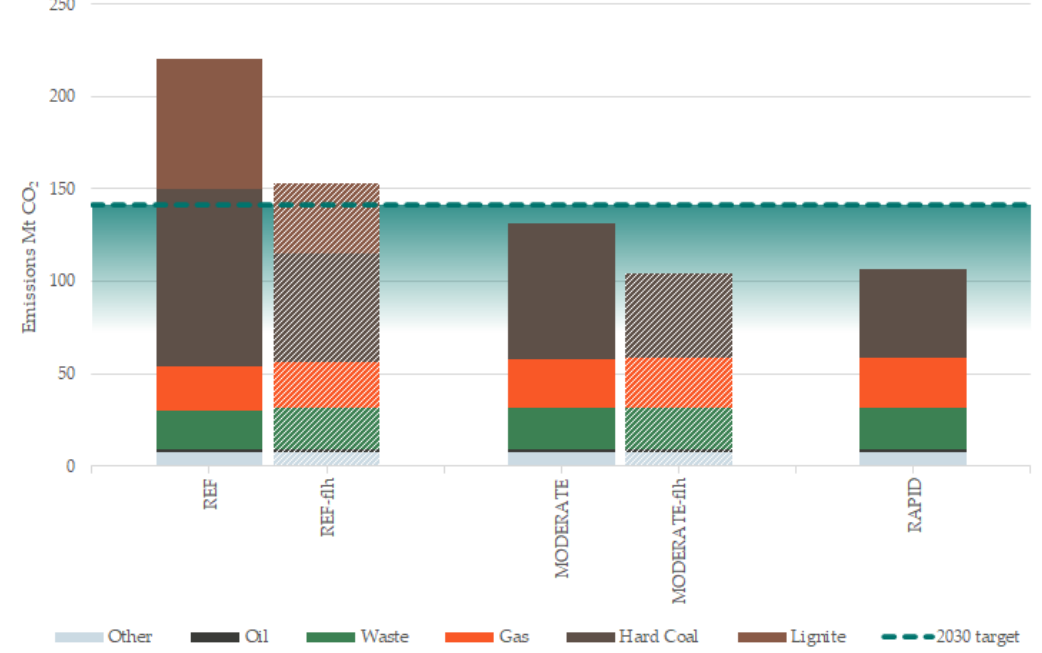
Figure 5. Emissions of the German electricity sector in 2030 (own calculations).